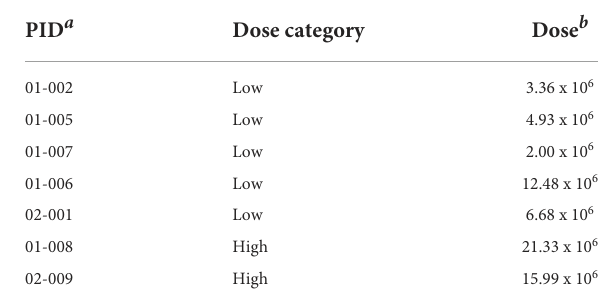
TABLE 3 AGT103-T cell product